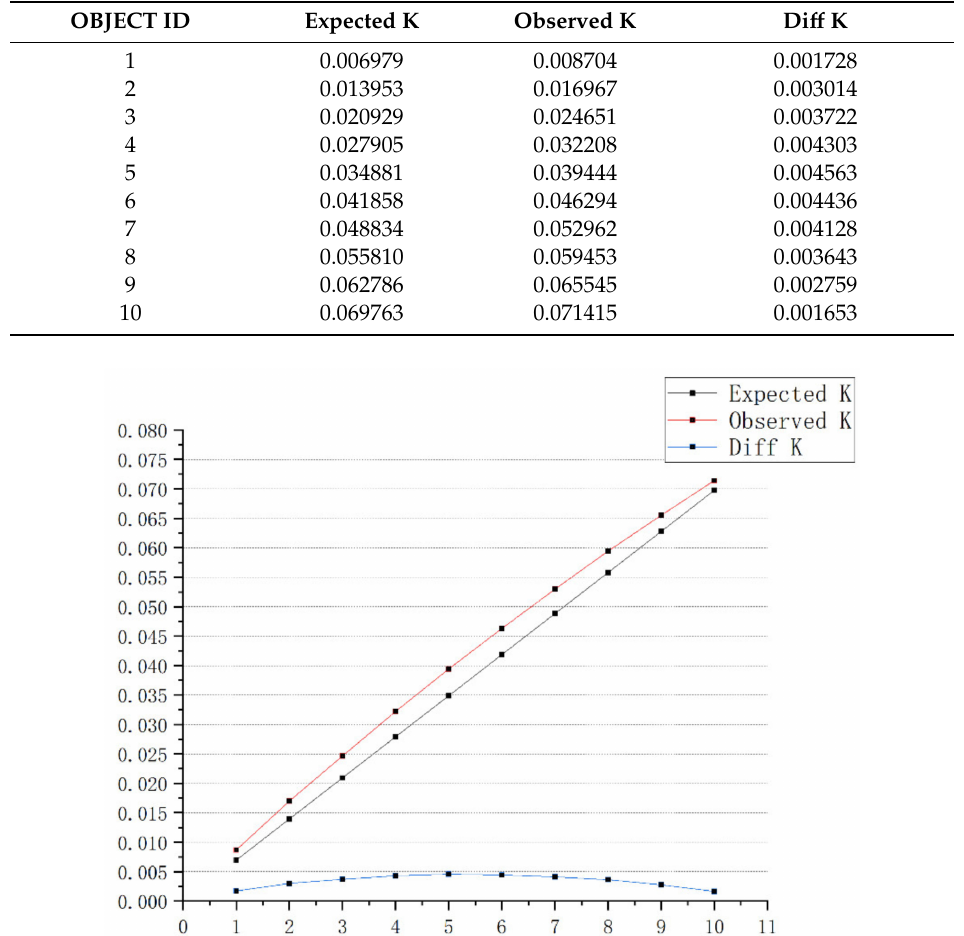
Table 1. Results of Ripley’s K analysis of the imagery obtained on 14 June 2018 of Wuhan city.